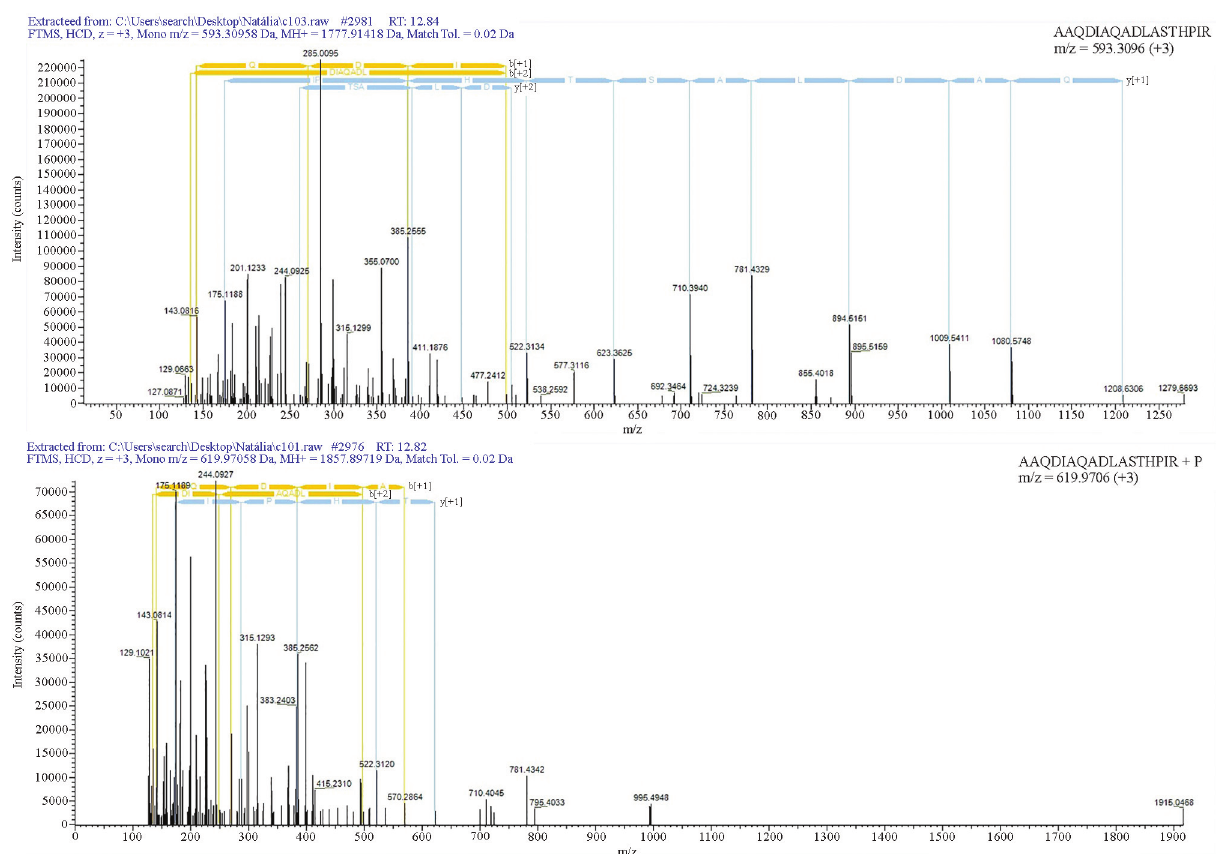
Figure 3 - Tandem mass spectra of the peptide AAQDIAQADLASTHPIR. The upper panel shows the nearly complete fragmentation pattern (with the acquisition of almost all y-ion series) of the non-phosphorylated precursor ion with m/z equal to 593.3096 (+3). The lower panel shows the fragmentation pattern of the same precursor ion with m/z equal to 619.9706